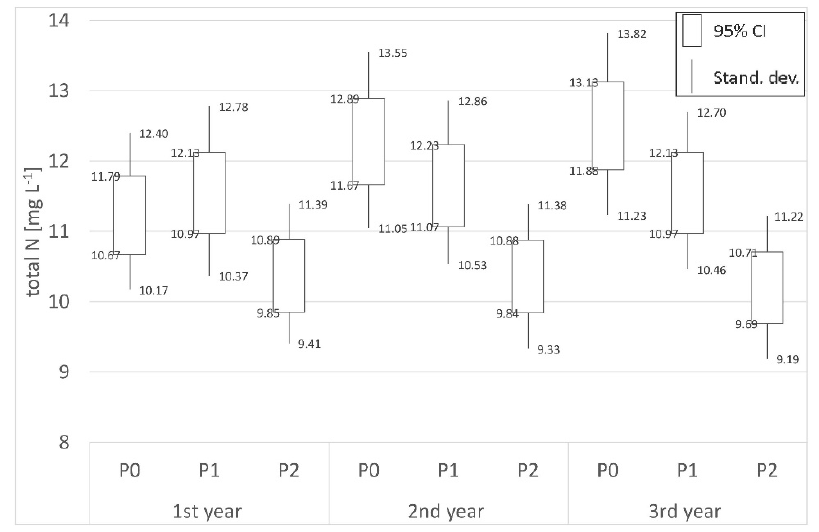
Figure 6. The concentrations of total N in groundwater under peatland soils.